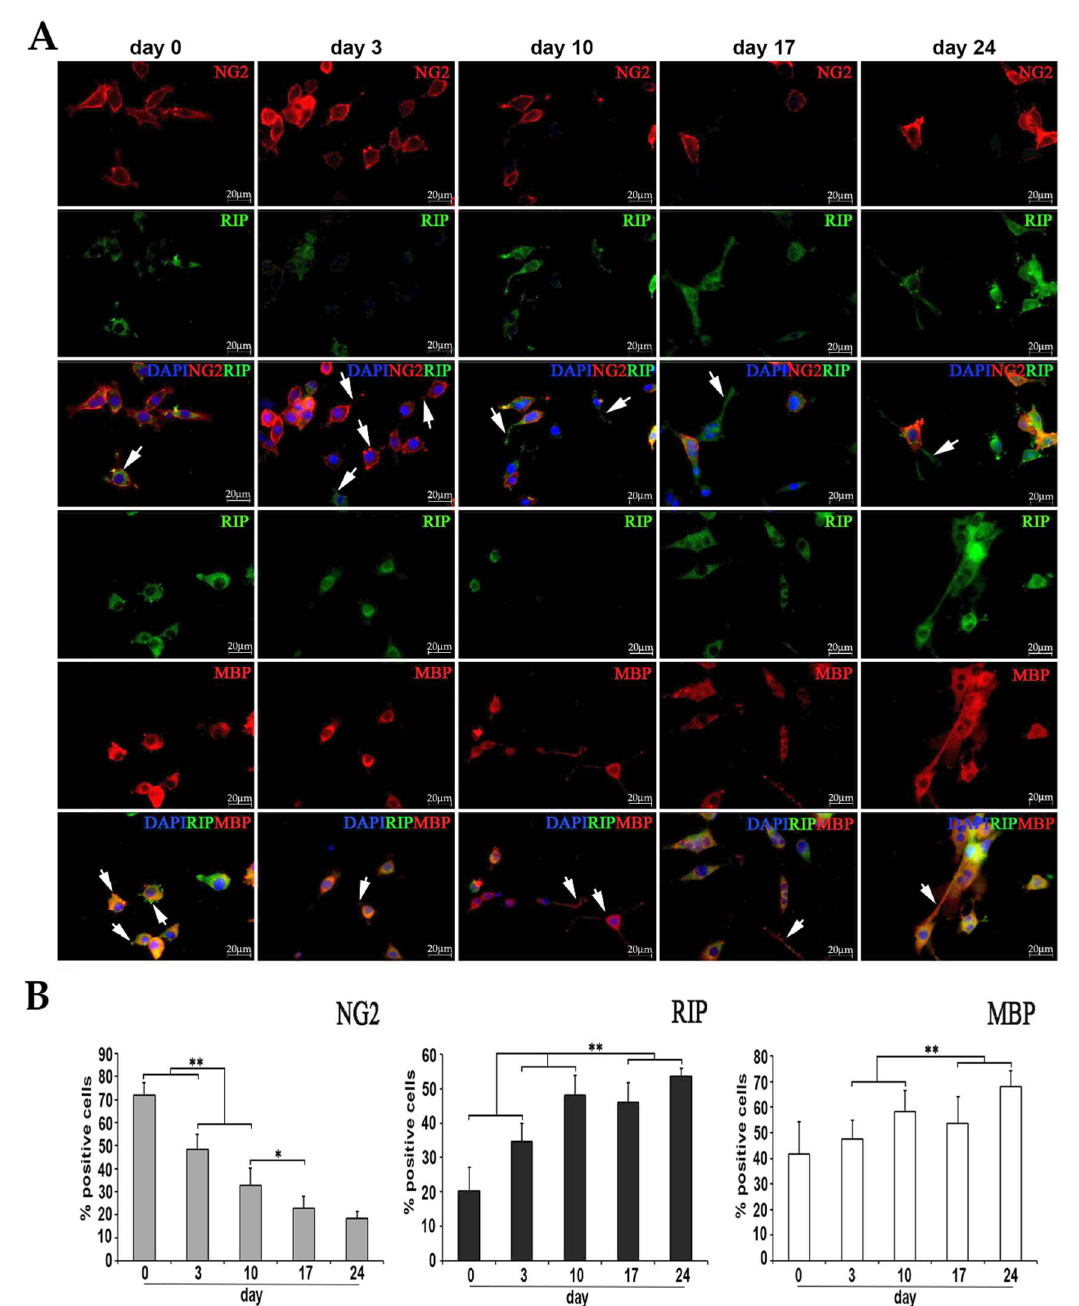
Figure 4. Characterization of diff-Ns by immunofluorescence. ( A ) Immunofluorescence analysis of the early oligodendroglial marker NG2 (red), and late oligodendroglial markers RIP (green), MBP (red) and DAPI nuclei (blue) in diff-Ns as described in Figure 3A. RIP positive cells were double-immunolabeled with NG2, for oligodendrocyte progenitors, or with MBP, for oligodendrocytes. ( B ) The percentage of positive cells was calculated by counting the number of NG2-, RIP- and MBP-positive cells as a proportion of blue DAPI positive nuclei. ** p < 0.01, * p < 0.05 day 3, 10, 17 or 24 versus the previous day of differentiation. Cells expressing oligodendroglial markers at the days 0 and 3 of differentiation branch short processes from a round and small body (arrows) and extend slender longer branches from a flattened and larger cell body at the late days of differentiation (arrows). Scale bar = 20 µ m. Magnification, 63 × To investigate if diff-Ns cells also express GFAP and NeuN, NG2-positive cells were double immunolabeled with NeuN while RIP-positive cells were double immunolabeled with GFAP (Figure 5, supplementary figure S1). The late neuronal marker NeuN was ex- pressed by about 10-20% of the cells at all days of differentiation, except on day 3 when 32.89% ± 4.2% of cells were positive for this marker. The expression of GFAP was limited